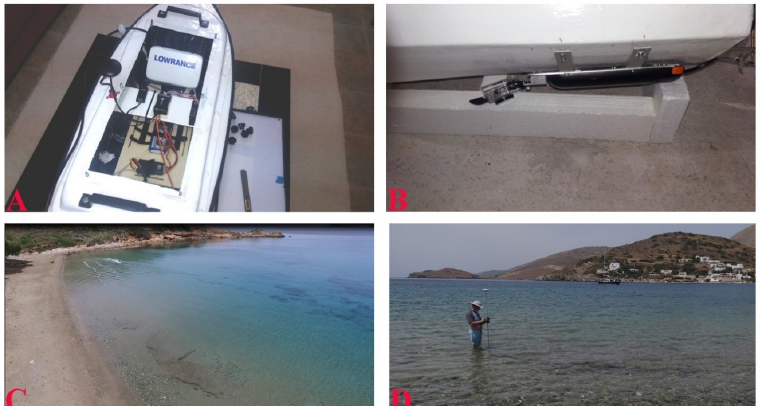
Figure 5. The equipment used in the fieldwork. ( A ) The Lowrance topside unit placed inside the unmanned surface vehicle (USV) and ( B ) the sonar transducer placed under the USV keel. ( C ) Photo captured from the UAV showing the USV data collection. ( D ) GNSS measurements in shallow water.